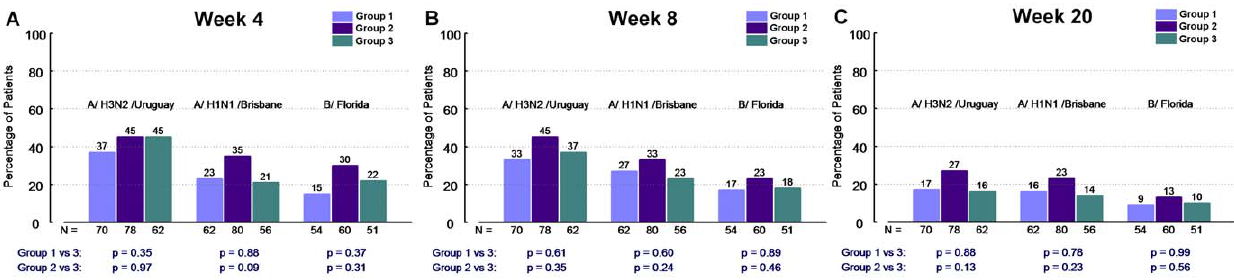
Figure 3. Patients with baseline HAI titres # 10: proportion achieving seroprotection (titres $ 40). The proportion of vaccine recipients with baseline HAI titres # 10 achieving seroprotection (titres $ 40) are described at week 4 (i.e. 4 weeks following the initial vaccination), week 8 (i.e. 8 weeks following the initial vaccination and 4 weeks following the booster dose in groups 1 and 2), and week 20. The HAI titre response is described for each of the three antigens included in the administered vaccine (A/H3N2/Uruguay, A/H1N1/Brisbane, B/Florida). Group 1 (single dose followed by single dose booster at week 4), Group 2 (double dose followed by double dose booster at week 4) and Group 3 (single dose without booster at week 4) are